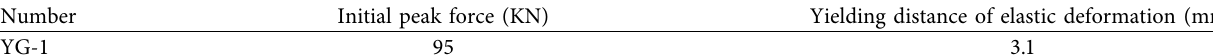
Figure 6: Performance evaluation parameters of the simulation of component crushing and buckling of various schemes. (a) Initial peak force, (b) displacement during the elastic stage, (c) effective deformation yield stroke, (d) total absorbed energy, (e) average reaction force, and (f) mean square deviation. Table 2: Performance evaluation parameters of thin-walled round pipes without hollowing out.